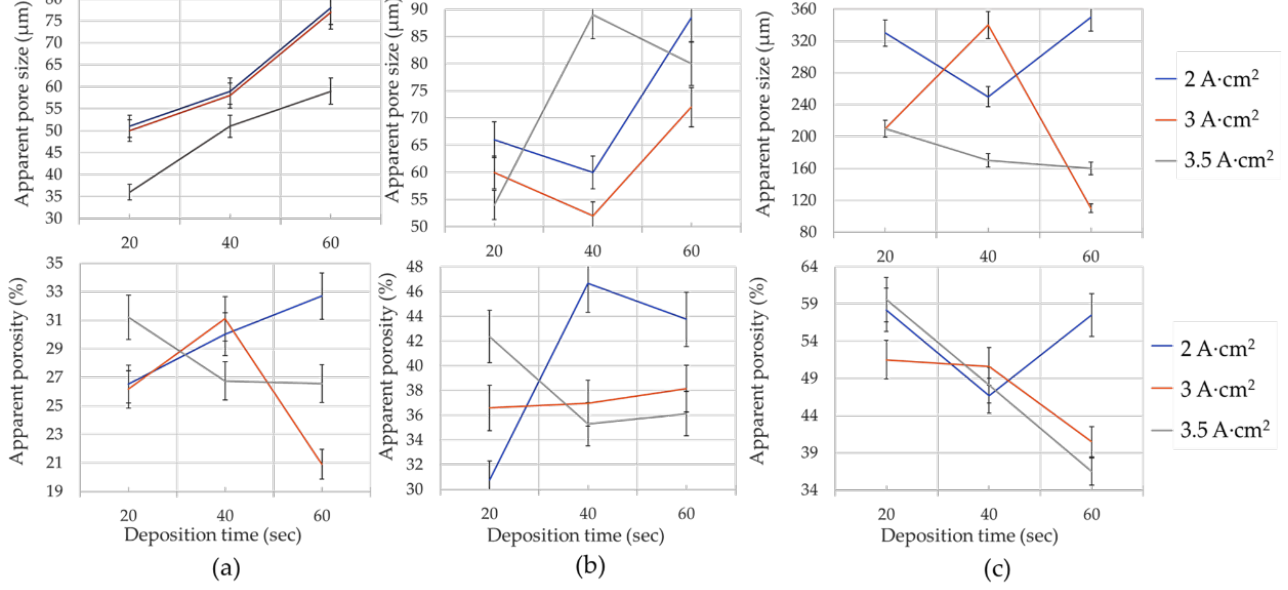
Figure 3. Apparent pore size and apparent porosity of the Cu electrodeposits in groups ( a ) A, ( b ) B, and ( c ) C. Figure 2b shows the morphology of the samples in group B. Similar to those in group A, applied current density and deposition time appear to influence apparent pore size more than porosity. Overall, considering the same sets of plating parameters, the group B samples exhibit either similar or higher apparent pore size and apparent porosity as